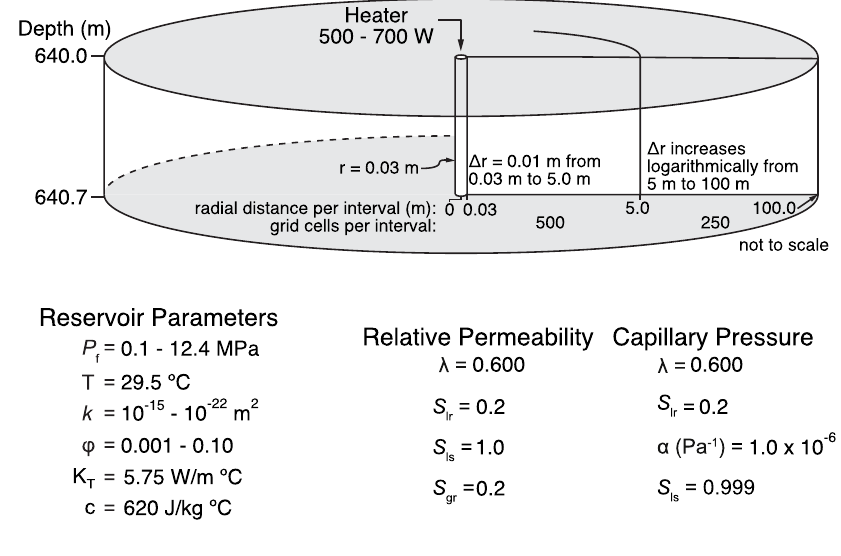
Figure 5. Schematic illustration and model properties for the 1D cylindrical model domain used for this study. The permeability and porosity values shown cover the ranges for both fracture (10 − 15 –10 − 18 m 2 and 0.001 to 0.10 for ensemble simulation) and intact salt (10 − 22 m 2 and 0.001, respectively). The heater grid cell radius is 0.03 m. The next 500 0.01-m grid cells reach 5.03 m, another 250 grid cells increase with a constant factor compared to their neighbor and are added to represent semi-infinite later dimensions of 100 m. The DRZ is defined as an area extending 1.25 m from the heater. The DRZ is composed of 124 matrix and 124 fracture grid cells as described by the MINC method.